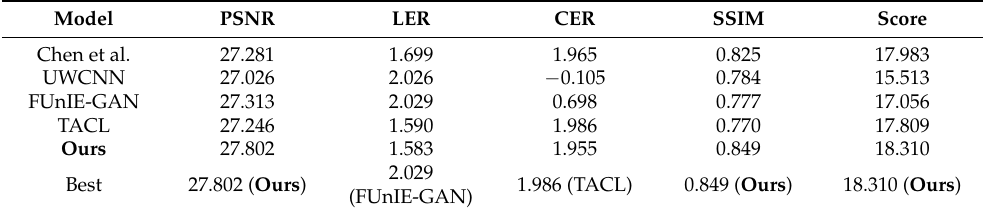
Table 3. Quantitative comparison between the proposed model and other methods in Figure 11. Model PSNR LER CER SSIM Chen et